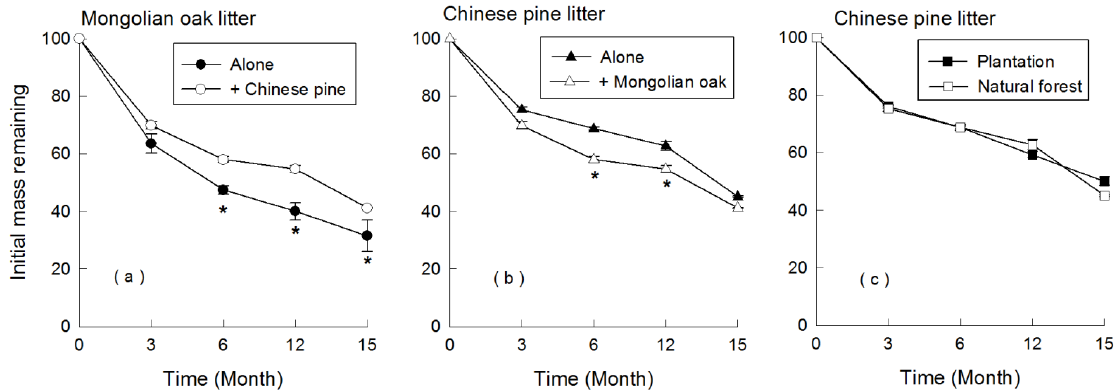
Figure 1. Percentages of remaining mass (%) for each leaf litter. ( a ) Mongolian oak litter in the natural